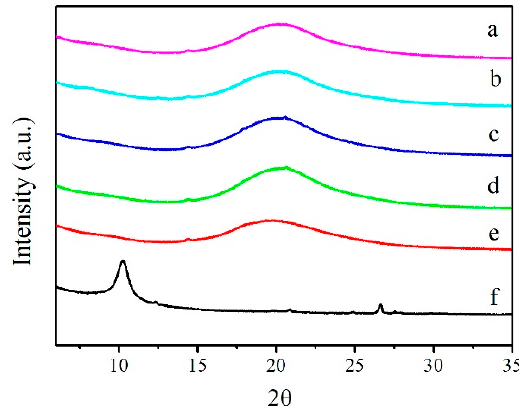
Figure 3. X-ray diffraction (XRD) patterns of LCPU ( a ); LCPU5 ( b ); LCPU with 10 wt % GO (LCPU10) ( c ); LCPU with 15 wt % GO (LCPU15) ( d ); LCPU with 20 wt % GO (LCPU20) ( e ); and GO ( f ).